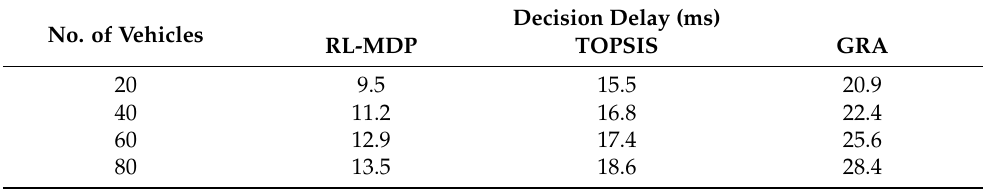
Table 4. Comparative analysis of decision